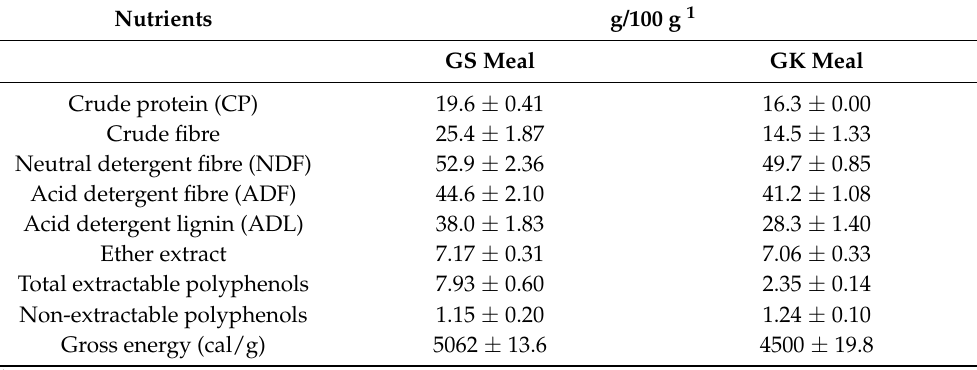
Table 1. Proximate composition (% dry matter) of grape seed (GS) and grape skin (GK) meals.